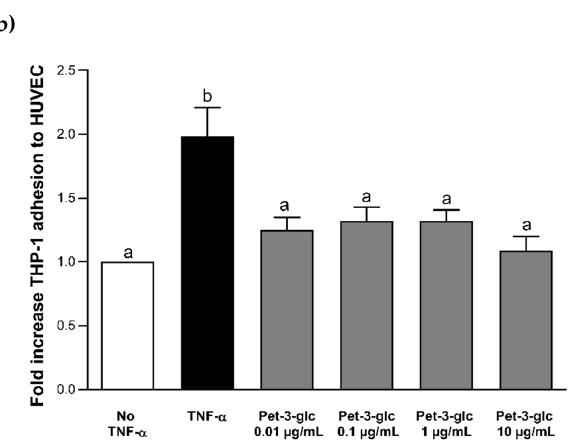
Figure 2. Effect of different concentrations (0.02–20 µM) of Peo-3-glc ( a ) and Pet-3-glc ( b ) on THP-1 (monocytes) adhesion to HUVECs (vascular endothelial cells). Results are expressed as mean ± standard error of mean. a,b,c Bar graphs reporting different letters are significantly different ( p ≤ 0.05). Nutrients 2020 , 12 , 655